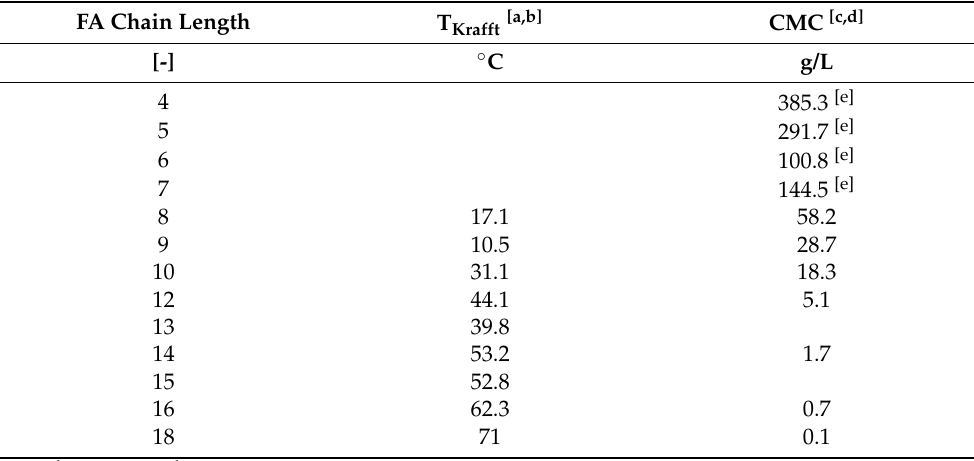
Table 2. Krafft temperature and critical micelle concentration (CMC) of different sodium soaps; CMC at 25 ◦ C, unless stated